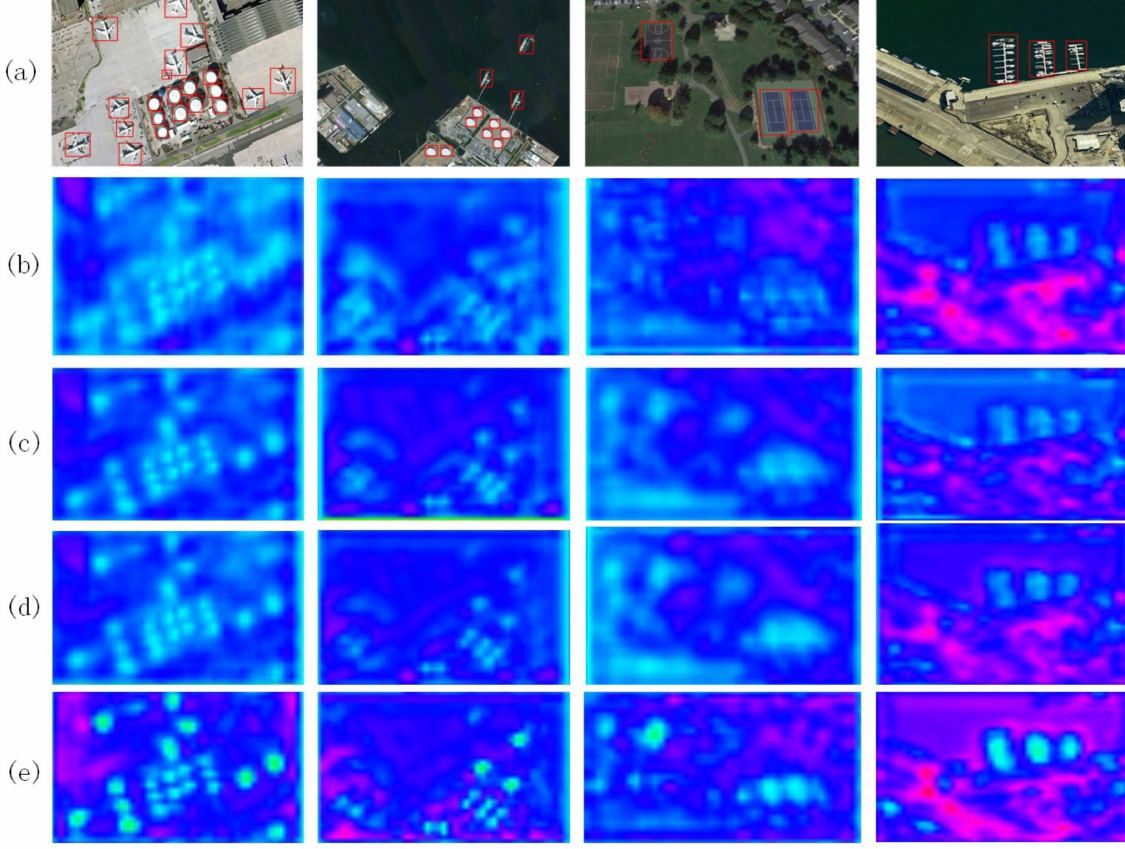
Figure 16. Feature maps of each conv5 in three networks. ( a ) Input images. ( b ) Without ORSG and AMIM. ( c ) With ORSG and max-pooling. ( d ) With ORSG and average pooling. ( e ) With ORSG and